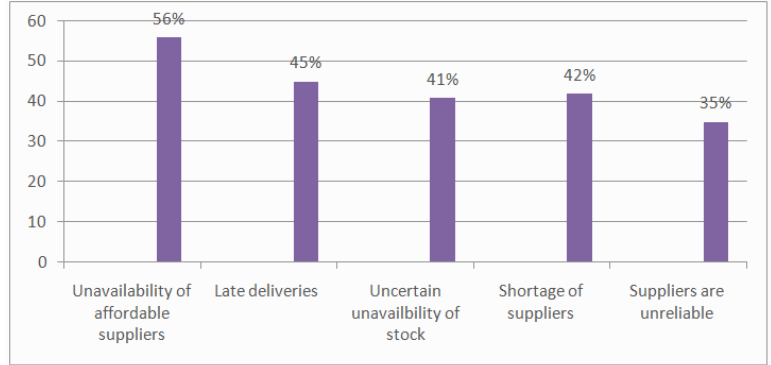
Fig. 3. Supplier related challenges